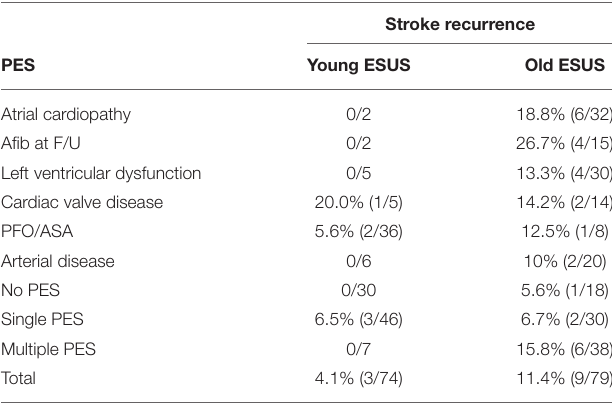
TABLE 4 | Recurrent embolic stroke by type and number of